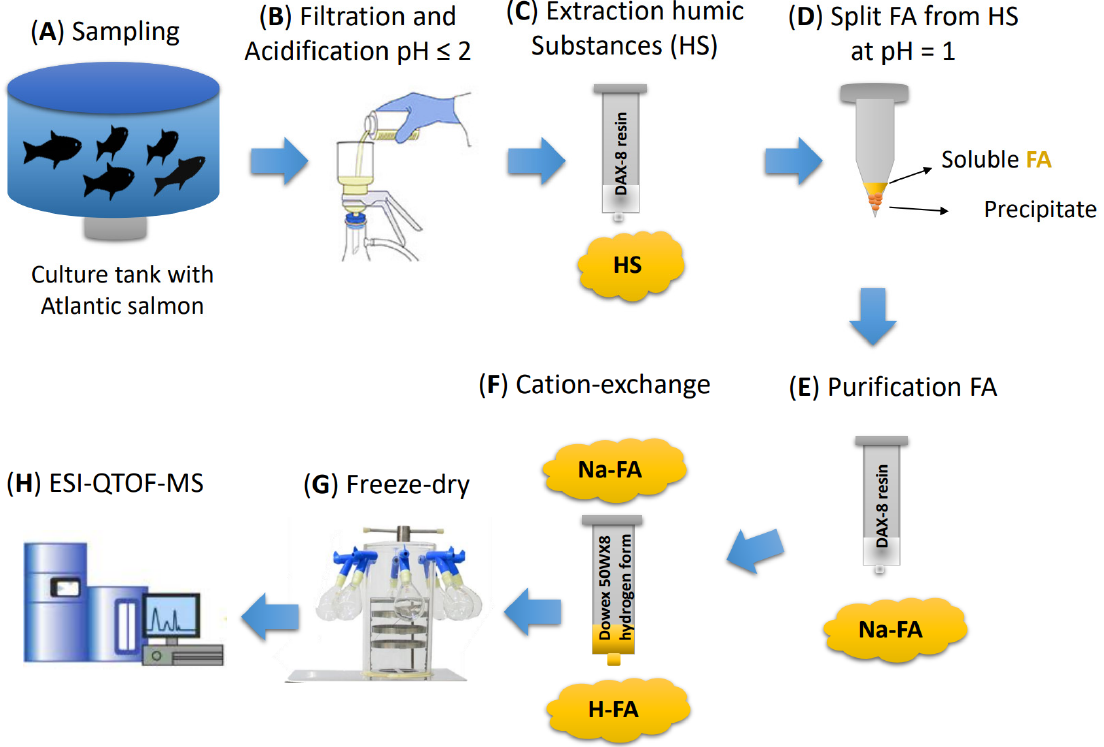
Figure 1. Overview of the fulvic acids (FA) isolation procedure based on Thurman and Malcolm, (1981) [48]. After sampling tank waters ( A ), the water was filtered with pre-combusted glass microfiber GF/F 0.7 µ m pore size filters and acidified with hydrochloric acid (HCl) to pH ≤ 2 ( B ). The humic substance (HS) fraction of dissolved organic matter (DOM) was extracted by solid-phase extraction (SPE) with 2 g of DAX-8 resin ( C ) and the soluble FA fraction was separated from the precipitate at pH = 1 ( D ). The FA fraction was re-adsorbed in 2 g of DAX-8 resin for purification ( E ), and the eluent with the FA in the sodium form (Na-FA) was passed through 2 g of a strong cation- exchange resin in hydrogen form to extract the protonated FA form (H-FA) ( F ). The H-FA eluent was freeze-dried ( G ) and prepared for negative ESI-QTOF-MS analysis ( H